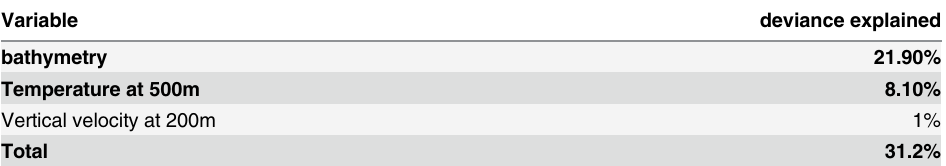
Table 3. Variables in the GAMM for short-finned pilot whales and amount of deviance explained by